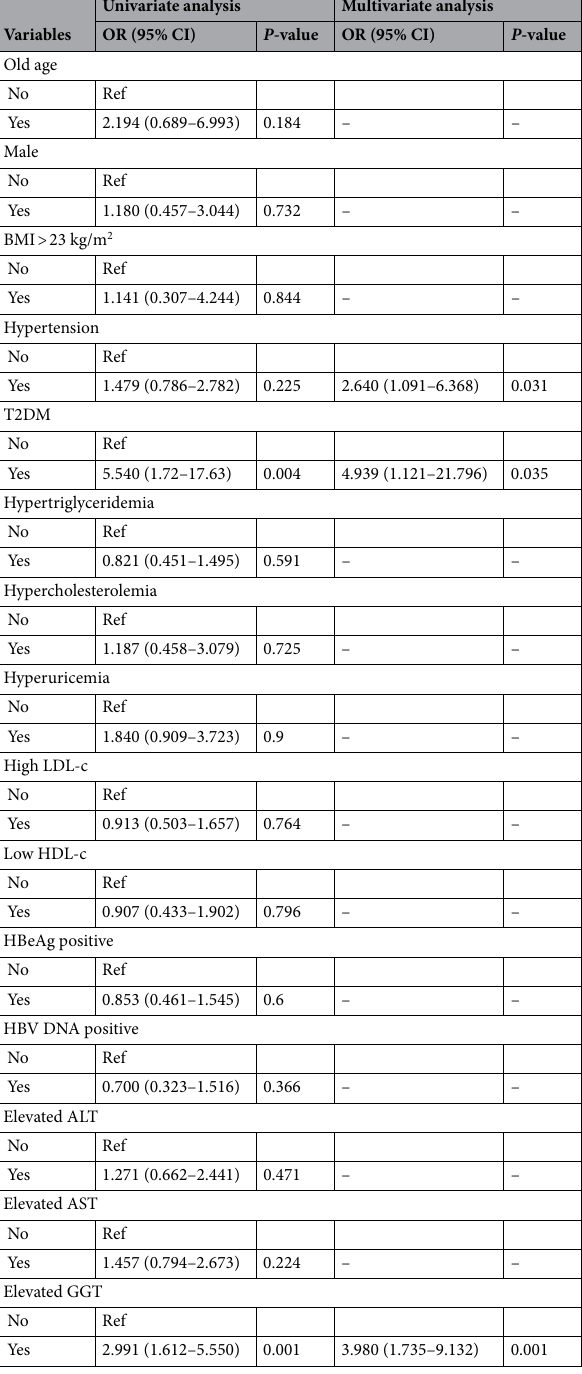
Table 4. Risk factors of liver fibrosis in metabolic dysfunction-associated fatty liver disease patients with hepatitis B virus infection. BMI body mass index, T2DM type 2 diabetes mellitus, LDL-c low-density lipoprotein cholesterol, HDL-c high-density lipoprotein cholesterol, ALT alanine aminotransferase, AST aspartate aminotransferase, HBeAg hepatitis B e-Antigen, HBV DNA hepatitis B virus deoxyribonucleic acid, GGT gamma-glutamyl-transferase, OR odds ratio, CI confidence